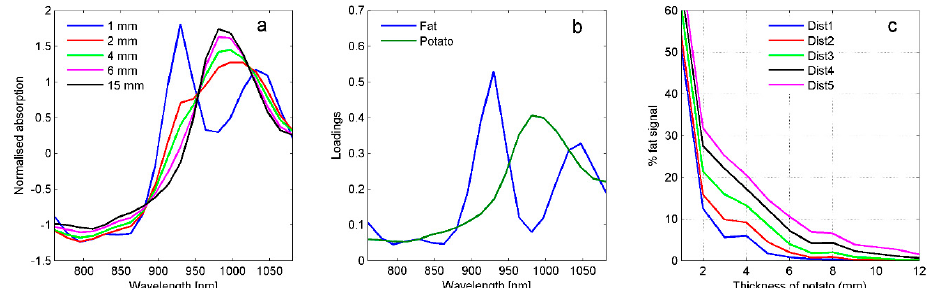
Figure 3. ( a ) SNV (standard normal variate)-corrected absorption spectra from potato slices of different thicknesses on a sample of coconut fat (shown for Dist4). ( b ) Pure spectra of fat and potato as estimated by MCR (multivariate curve resolution). ( c ) Estimated concentrations of fat as function of potato slice thickness for Dist1–Dist5.